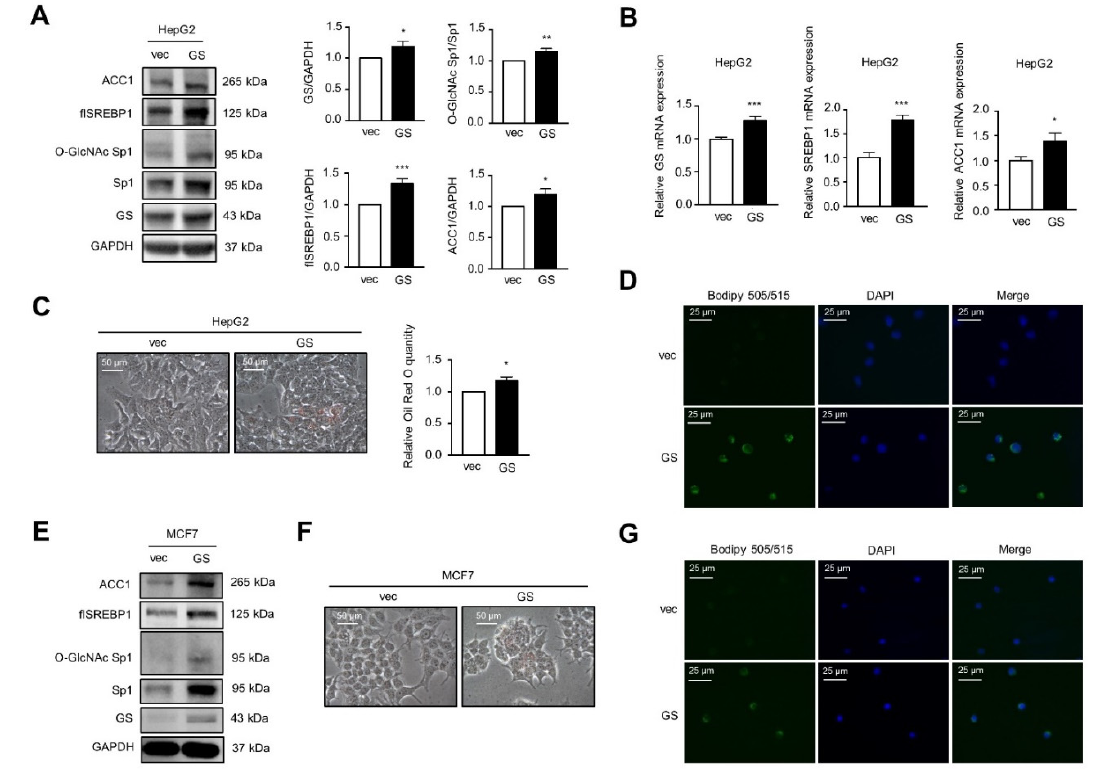
Figure 4. The overexpression of GS increases O-GlcNAc-Sp1/SREBP1/ACC1 expression and LD formation. ( A – D ) HepG2 cells stably transfected with vector or pBabe-GS were cultured. ( E – G ) MCF7 cells stably transfected with vector or pBabe-GS were cultured. ( A , E ) Cell lysates were analyzed by Western blot with specified antibodies. flSREBP1: full-length SREBP1. The bar graphs on the right represent the densitometry analyses of the ratios of indicated proteins. ( B ) Relative transcript levels were determined via qRT-PCR. ( C , F ) LD was stained with Oil Red O and normalized to protein concentrations for the quantitative analysis. Data represent means plus SEM. * p < 0.05, ** p < 0.01, and *** p < 0.001. ( D , G ) LD was stained with the BODIPY 505/515 (green) and the nuclei were stained with DAPI (blue).